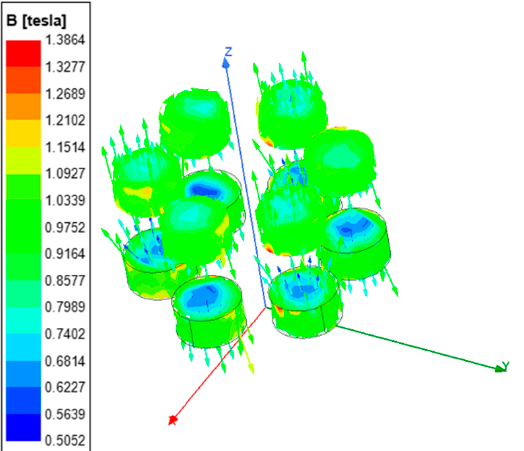
Figure 17. Magnetic flux density distribution of permanent magnet poles (at 1034.14 rad/s).